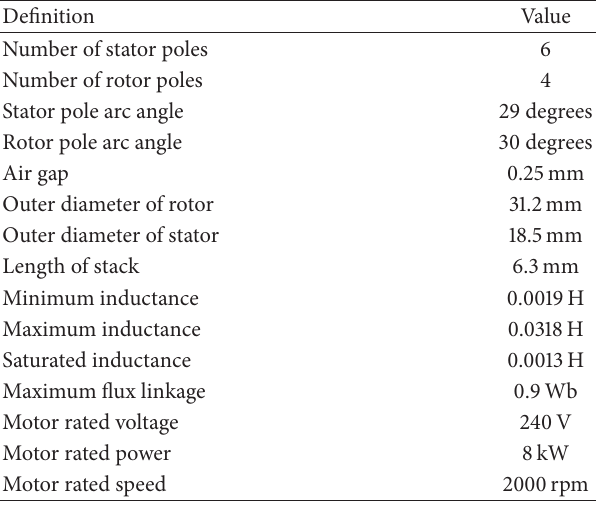
Table 4: Out-rotor 6/4 SRM nomenclature and